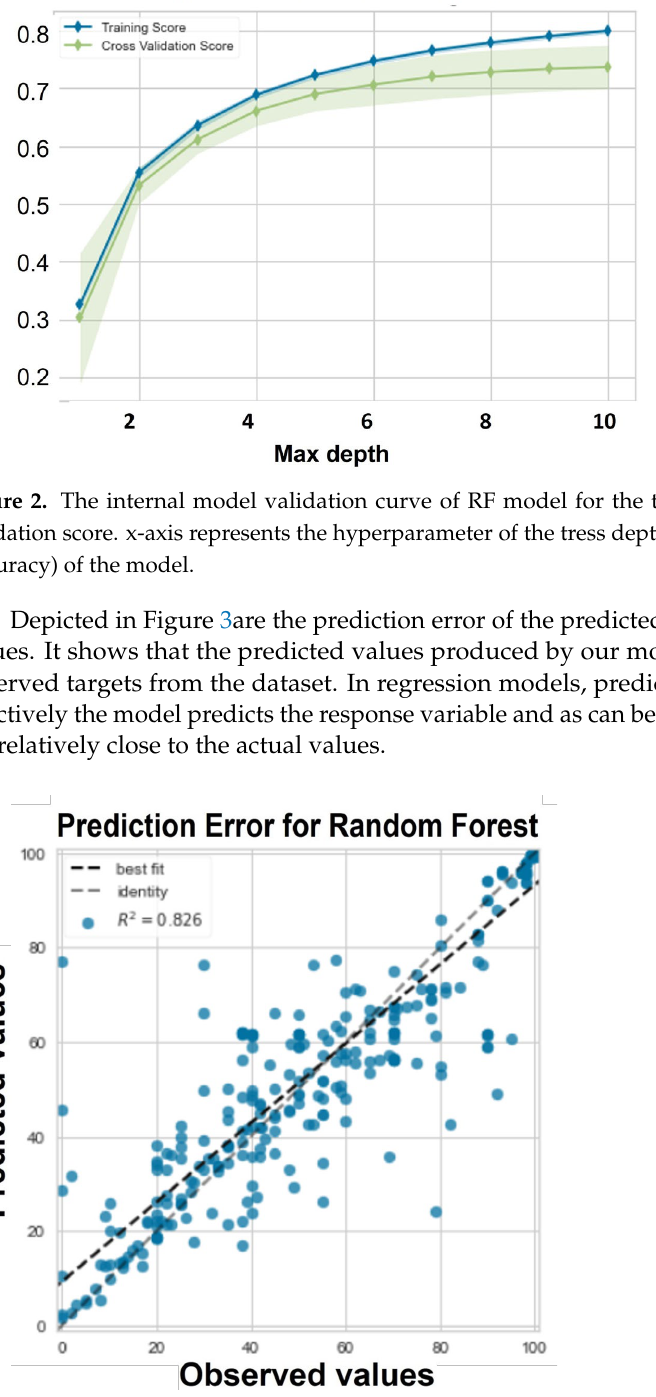
Figure 3. The prediction error by the RF regression model, the x-axis represents the actual (observed) values and the y-axis represents the predicted values.